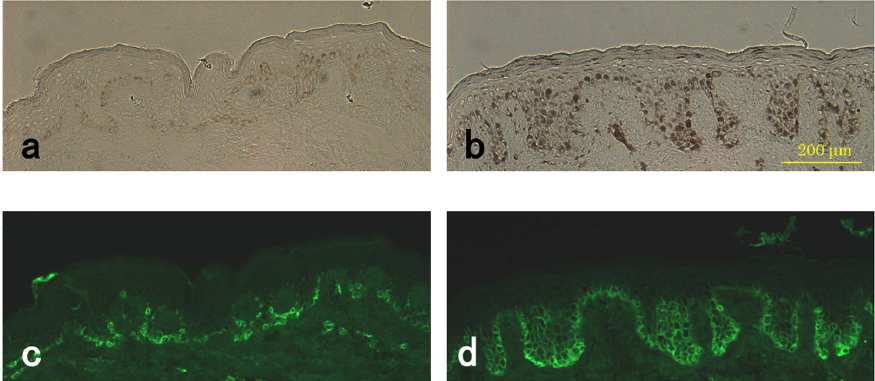
Figure 5. Detection of KIT in the SL lesion and perilesional normal skin using enhanced immunostaining methods. Representative sections of perilesional ( a , c ) and SL lesional ( b , d ) skin from the same subject (#4). Light microscope images ( a , b ) and immunostaining with KIT ( c , d